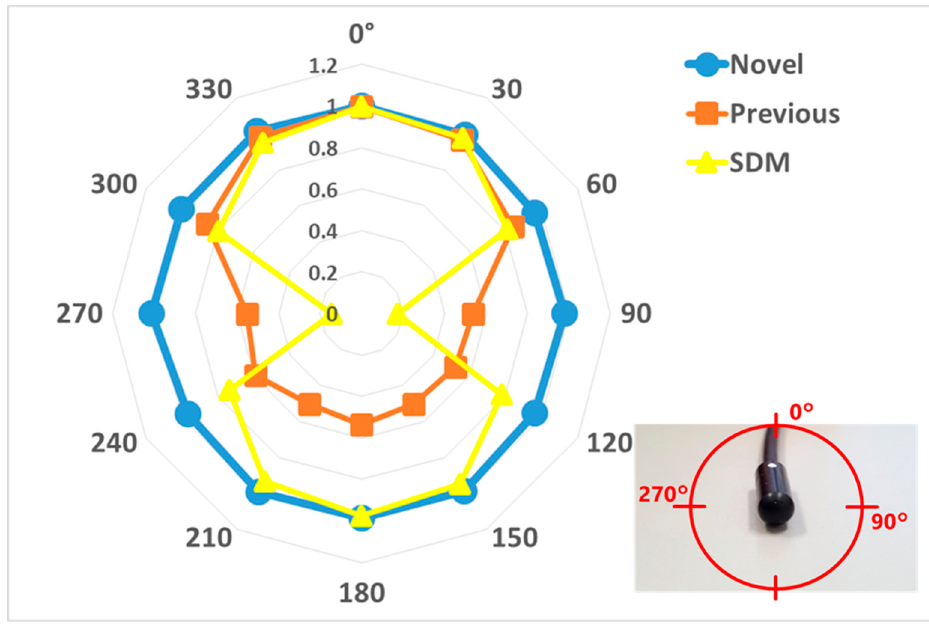
Figure 8. Angular dependence for horizontal axis compared with the novel, previous sensors and SDM.